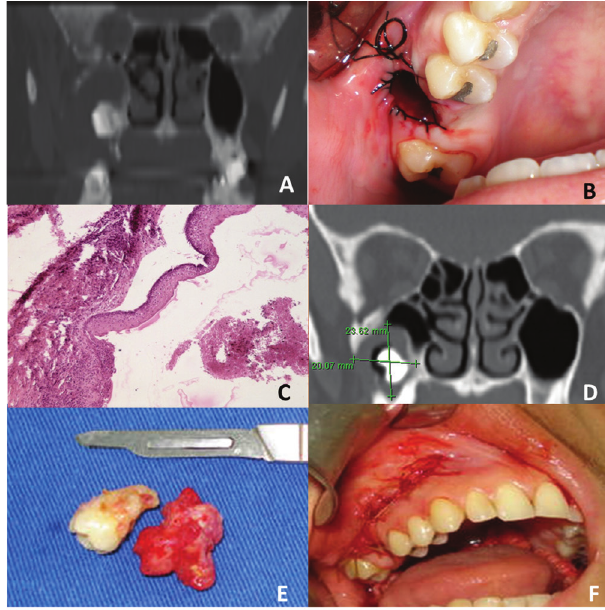
Figure 1 A, Coronal view of computed tomography showing the obstruction of the right maxillary sinus by a lesion of cystic aspect associated with a molar tooth. B, Decompression of the lesion under local anesthesia. C, Coating epithelium parake- ratinized H & E with 100 × magnification. D, Coronal view at 18 months postoperative. E, Removal of cyst and the associated tooth. F, Primary closure of